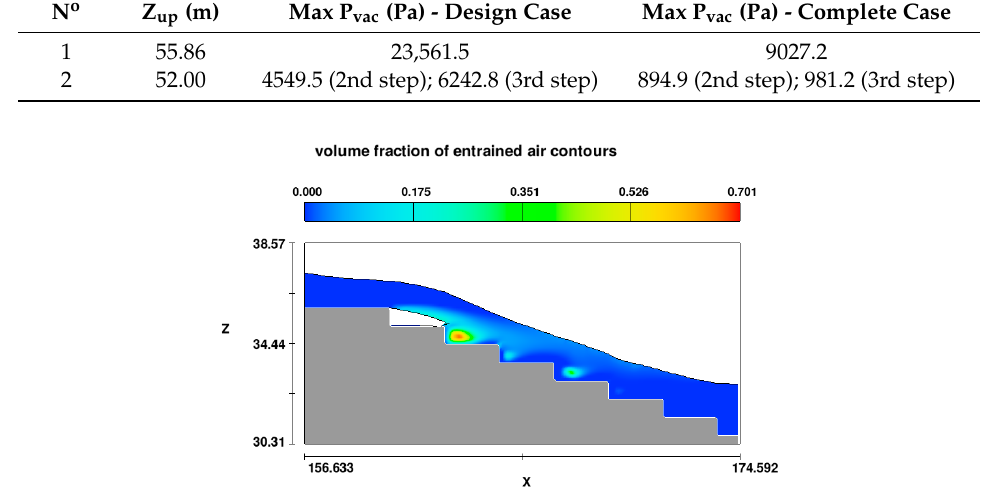
Figure 12. Volume fraction of entrained air at stepped segment in complete case, Z up = 52m.